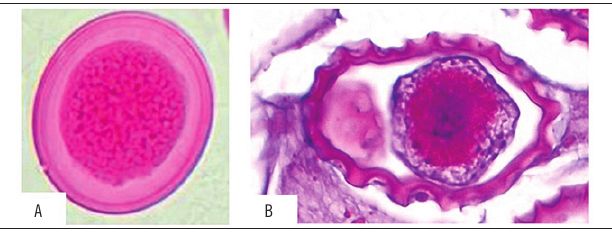
figurE 5 − Comparison between eggs of Ascaris lumbricoides and Lagochilascaris minor A) the A. lumbricoides egg membrane is regular; B) the L. minor egg membrane is dentate, with “soda cap”